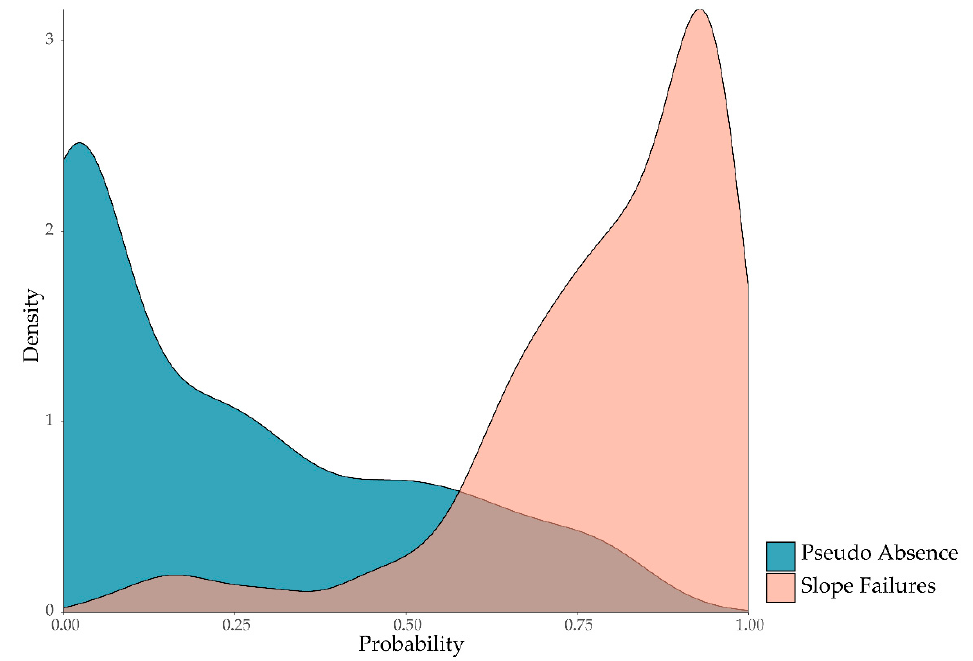
Figure 4 represents the distribution of predicted probabilities for the withheld validation data using a kernel density function. In support of the 0.946 AUC value obtained for the combined model, this plot suggests a strong separation between slope failure samples and random pseudo absence data. The median probability for the slope failure locations is 0.84 while the median probability for the pseudo absence points is 0.15. Of the slope failure points, 92.6% have a predicted probability higher than 0.50 while only 18.5% of the pseudo absence data have a probability higher than 0.50. Using a probability threshold of 0.5, the overall accuracy for predicting the validation data is 87.1% and the Kappa statistic is 0.742. For the slope failure class specifically, precision is 0.834 and recall is 0.926. The resulting prediction across the entire mapped extent and some example areas at a larger scale are provided in Figure 5. Red areas are those that are predicted to have a high likelihood of slope failure occurrence while green areas are predicted as having a low likelihood. Based on a visual inspection, the figure suggests a strong relationship between predicted occurrence and topographic slope and incision.